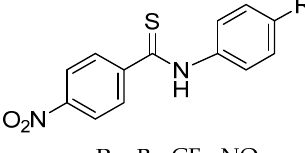
Figure 2. Thiobenzanilide derivatives active against melanoma A375 cell line [21]. More recently, Kucinska et al. [22] have also studied a series of thiobenzanilide derivatives having found that three of them had antiproliferative activity against estrogen- dependent MCF-7 breast cancer cells and that, in addition, one of them was selective for those cells, being almost innocuous towards normal breast cells (Figure 3). Despite the fact that drugs approved for breast cancer treatment are efficient to inhibit cancer progression by a variety of different mechanisms, chemoresistance is still an important issue and one of the major challenges that patients have to face [23], justifying per se the search for new molecules with new targets or new mechanisms of action.